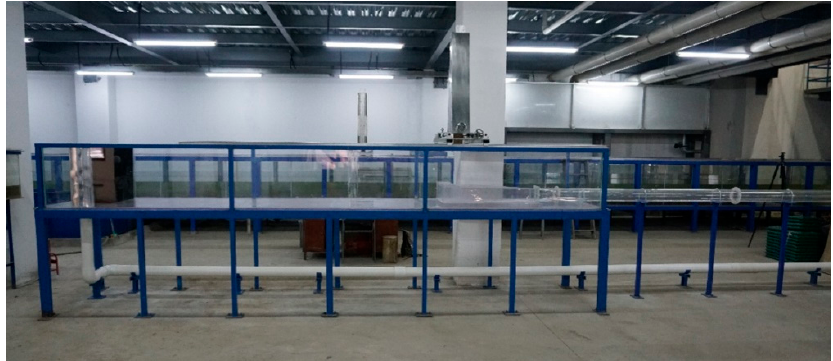
Figure 5. The experimental setup of the inlet/outlet.